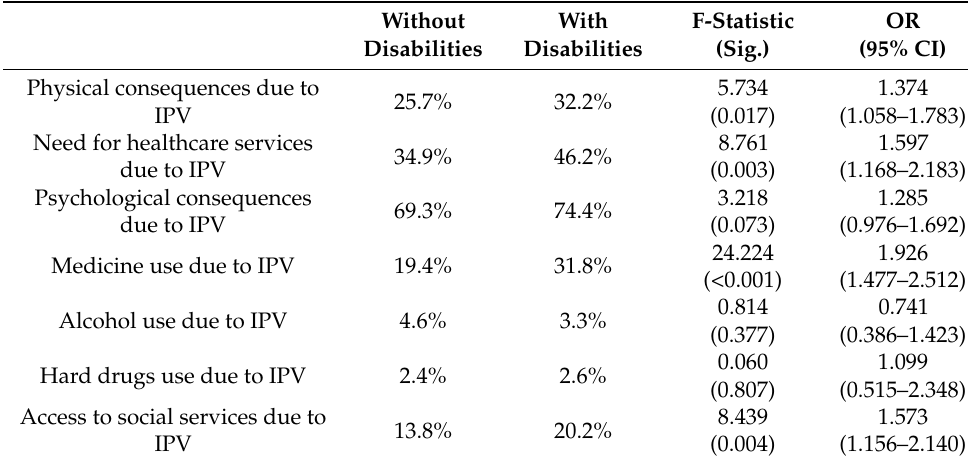
Table 4. Incidence of disability on IPV